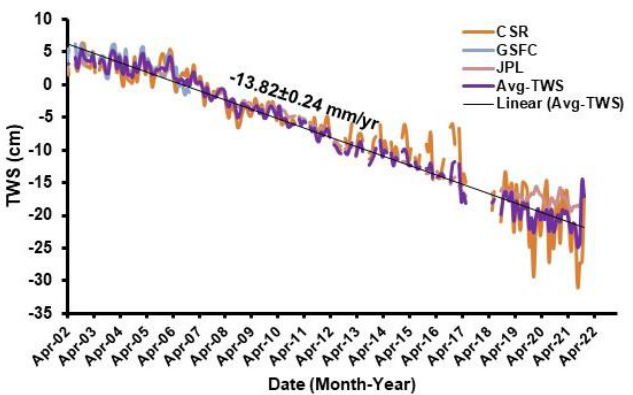
Figure 5. Monthly ∆ TWS time series of the three mascon solutions and their averaging for the Figure 5. Monthly ΔTWS time series of the three mascon solutions and their averaging for the study area. study 4.3. Temporal Variations in ΔSMS Given the low precipitation rates over the study area, the GLDAS- derived ΔSMS ex- hibits a very minor upward trend throughout the investigated period. The estimated ΔSMS trend from the three GLDAS versions (VIC, CLM, Noah) for the study period is +0.008 ± 0.004 mm/yr (Table 1; Figure 6). Additionally, depicted in Figure 6 is the spatial distribution of the SMS trend across the research area.